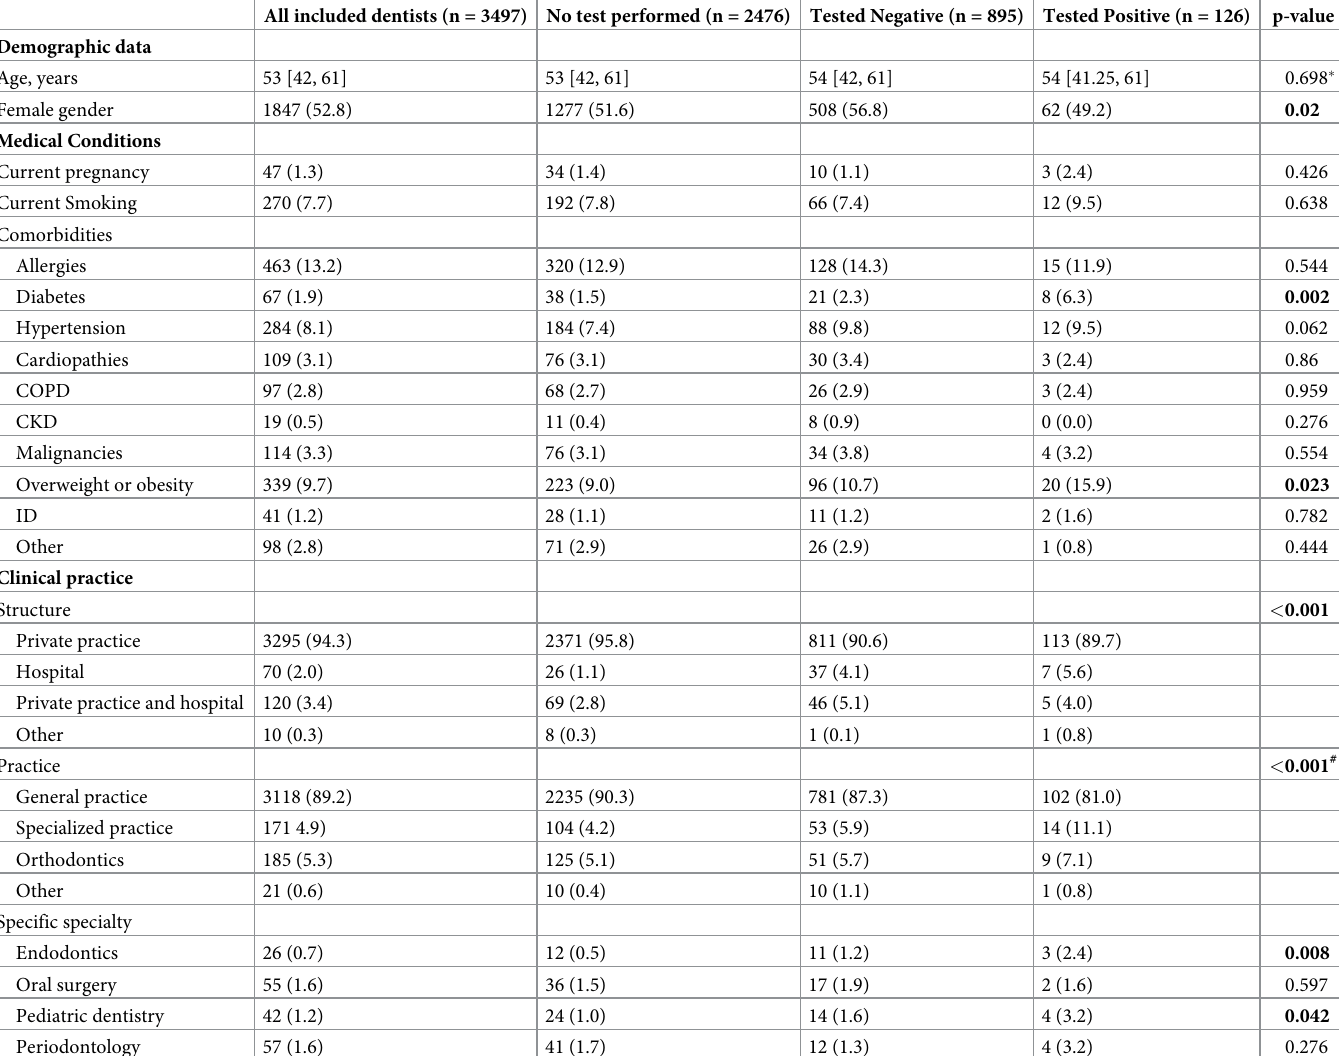
Table 1. Socio-demographic data, medical conditions, and clinical practice before the